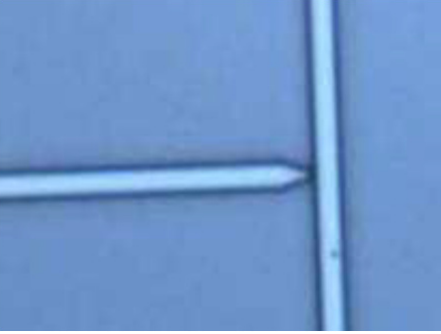
Figure 6. T-Shaped Droplet Generator chip